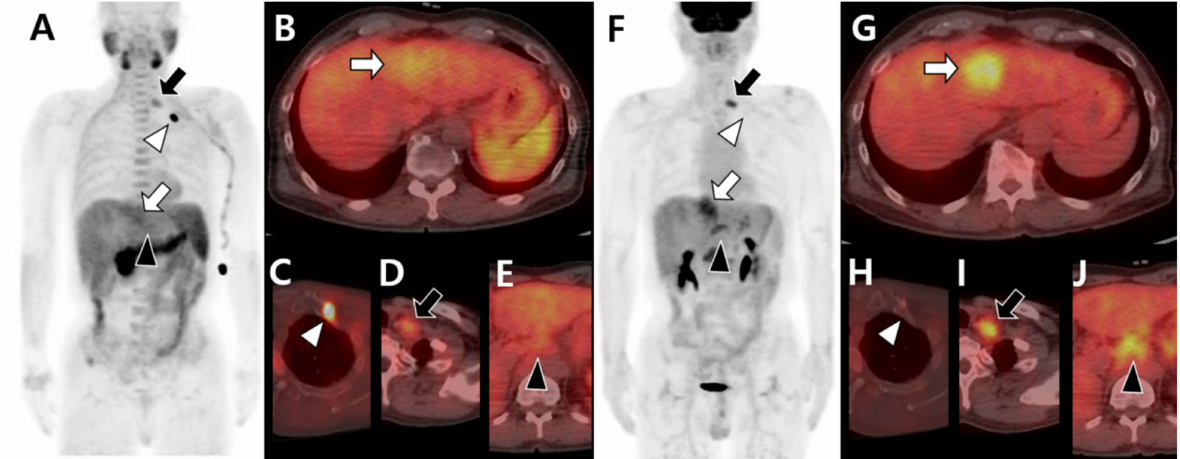
Figure 4. Different tracer avidity according to the metastatic organ in the same patient with hepatocellular carcinoma before therapy. 11 C-acetate positron emission tomography (PET)/computed tomography (CT) ( A – E ) shows mild uptake in the primary hepatic tumor (white arrow in A , B ). The metastatic bone lesion in the left first rib shows intense acetate uptake (white arrowhead in A , C ) but less acetate uptake in metastatic lymph nodes of the left supraclavicular (black arrow in A , D ) and common hepatic (black arrowhead in A , E ) areas. 18 F-fluorodeoxyglucose ( 18 F-FDG) PET/CT ( F – J ) shows intense uptake in primary hepatic tumors (white arrow in F , G ). There is no significant FDG uptake in the left first rib (white arrowhead in F , H ) but intense uptake in the left supraclavicular (black arrow in F , I ) and common hepatic (black arrowhead in F , J ) lymph